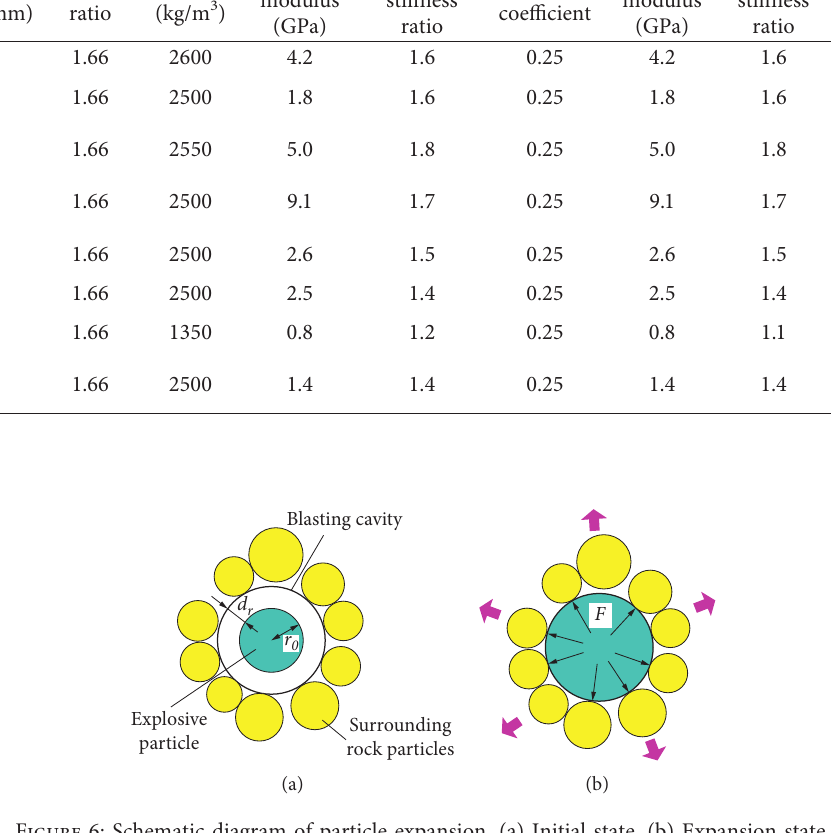
Figure 6: Schematic diagram of particle expansion. (a) Initial state. (b) Expansion